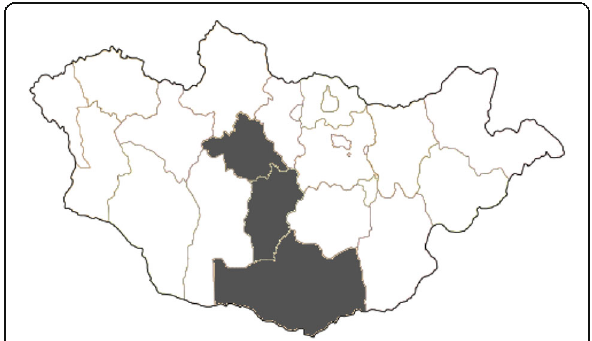
Figure 1 The study sites were in three aimags: Arkhangai (top), Uvurkhangai (middle), and Umnugobi